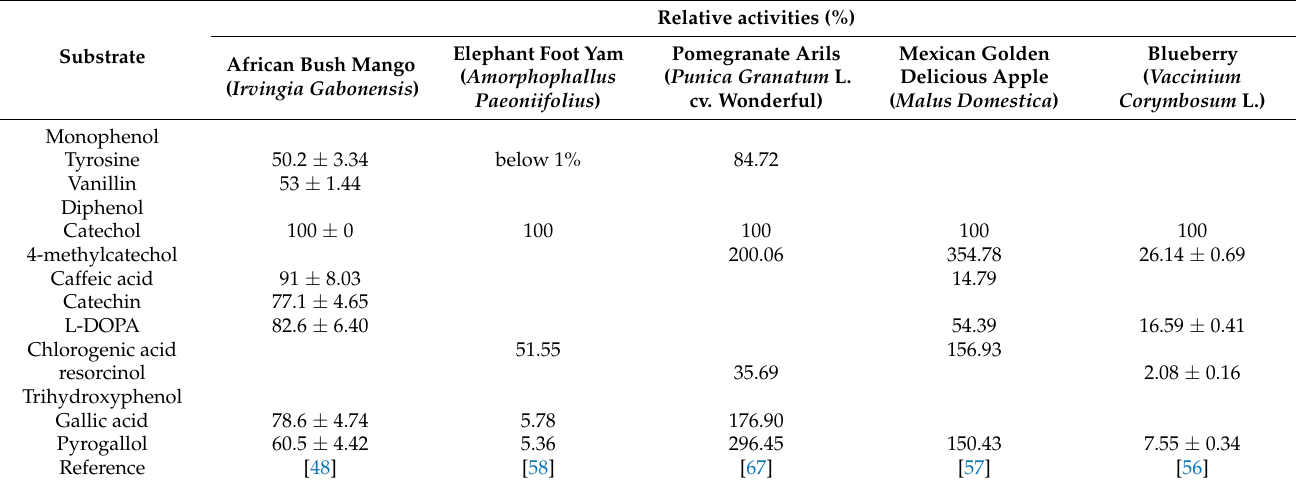
Table 3. Substrate specificity of PPO from different plant